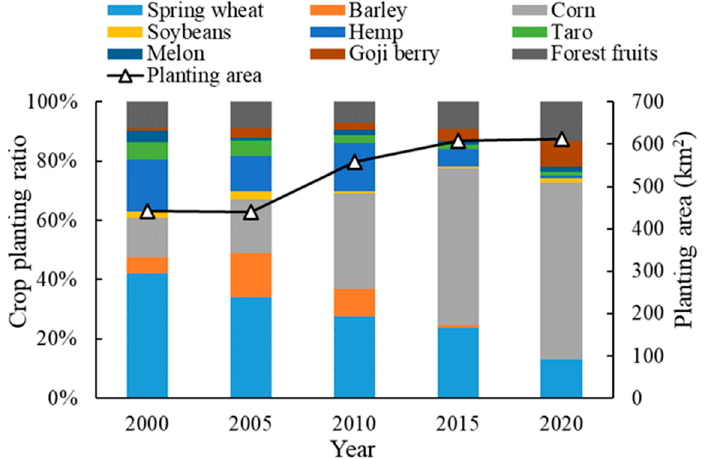
Figure 4. Crop planting area and proportion for typical years.